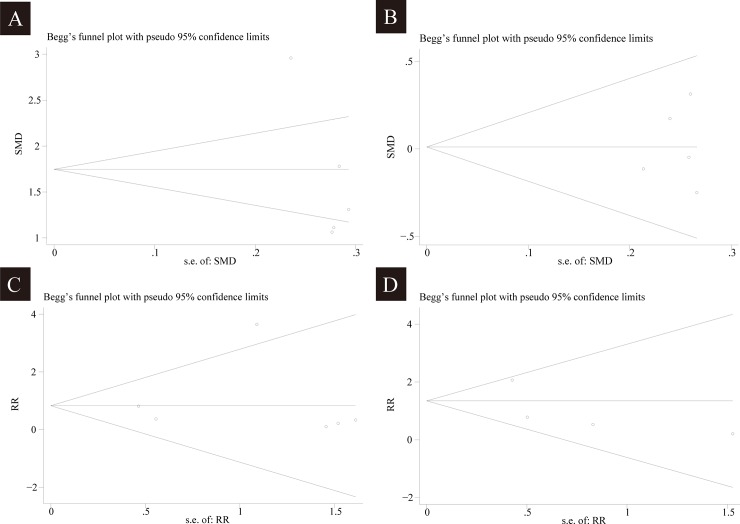
Funnel plots of effect estimates for various clinical outcomes.Notes: Dexmedetomidine vs Magnesium (A) the bleeding condition of surgical field: Egger’s tests, P = 0.047; (B) duration of surgery: Egger’s test, P = 0.812; (C) Bradycardia Incidence: P = 0.764; (D) Hypotension Incidence: P = 0.365. Abbreviations: RR, risk ratio; SE, standard error.